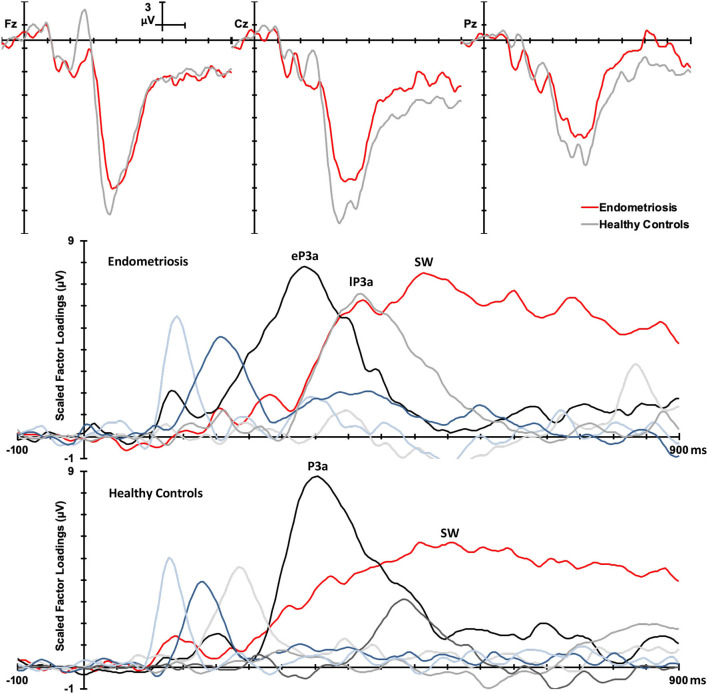
(Top) Grand mean ERPs (with negative plotted upwards) to non-target stimuli for the endometriosis (red) and HC (gray) groups at three midline sites (Fz, Cz, Pz). (Middle) Factor loadings for the 6 PCA components for the endometriosis group, with the identified eP3a (TF02), lP3a (TF03), and SW (TF01) components labeled. (Bottom) Factor loadings for the 7 PCA components for the HC group, with the P3a (TF02) and SW (TF01) components marked.